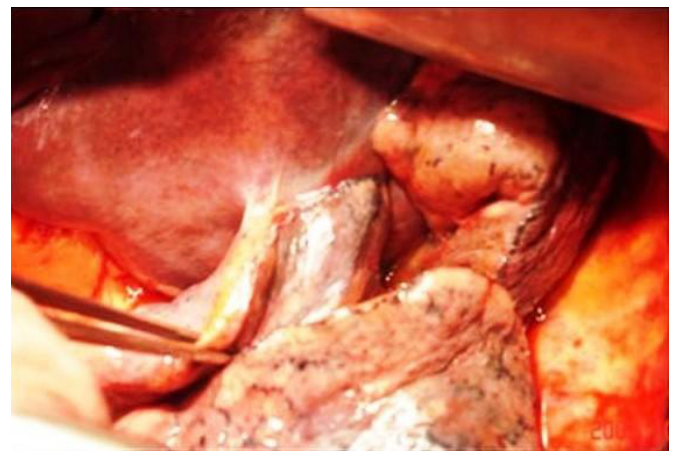
FIGURE 2. Liver herniation in the thorax with collapse of middle and lower lobes.